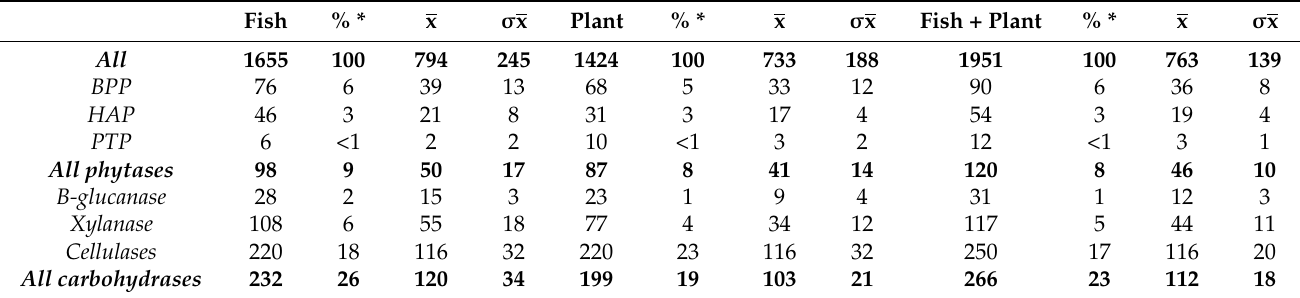
* % of total sequences from all three replicates or relative